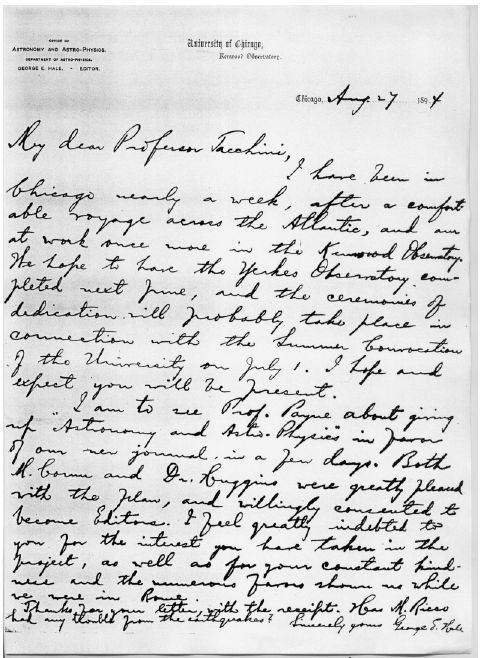
Fig. 4. A letter by George Ellery Hale (1868-1938) to